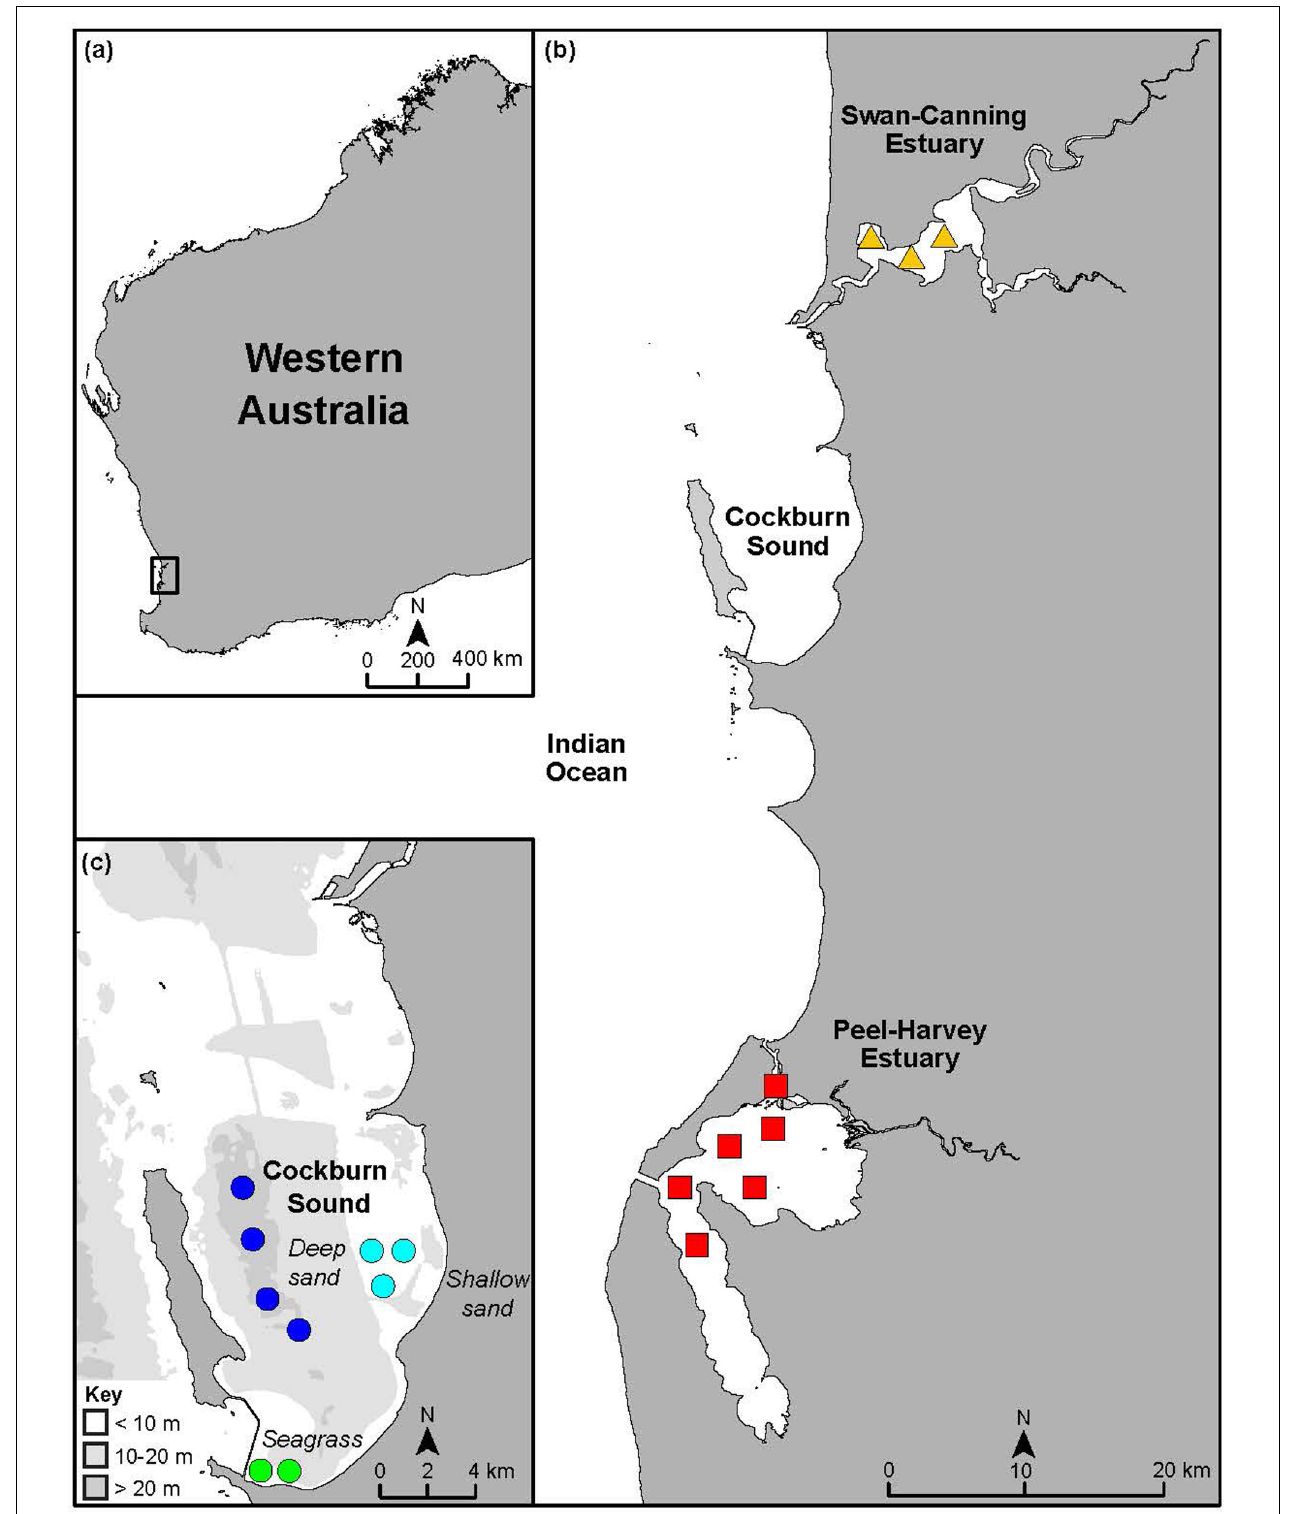
FIGURE 1 | Maps showing (a) the location of the study area in Western Australia, (b) sampling areas in the Peel-Harvey and Swan-Canning estuaries and the marine embayment of Cockburn Sound and (c) a bathymetric map showing sampling areas in Cockburn Sound and the three habitats it contains. Symbols denote the spatial areas from which samples of Portunus armatus were collected in each system and are not reflective of replicate sites.